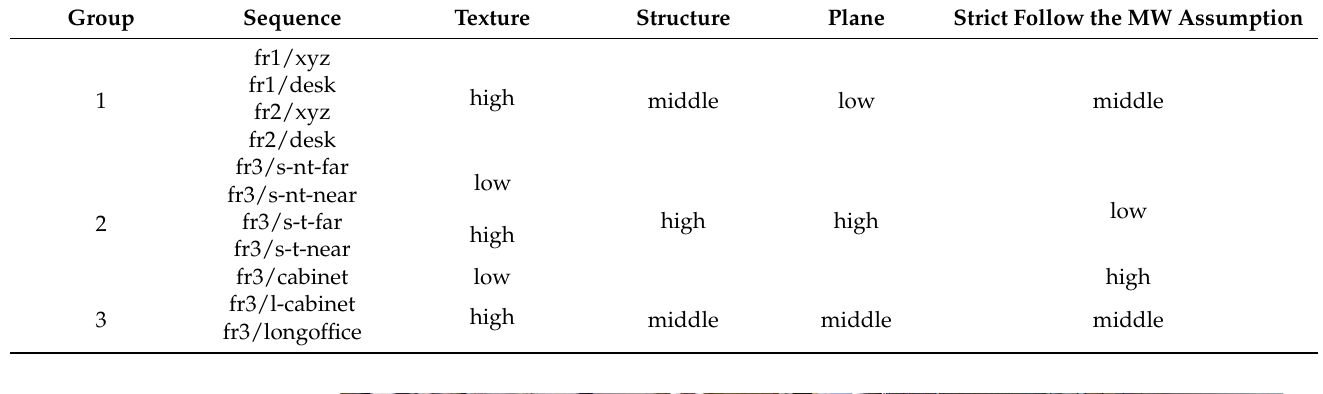
Table 3. Differences between sequences in TUM RGB-D dataset.